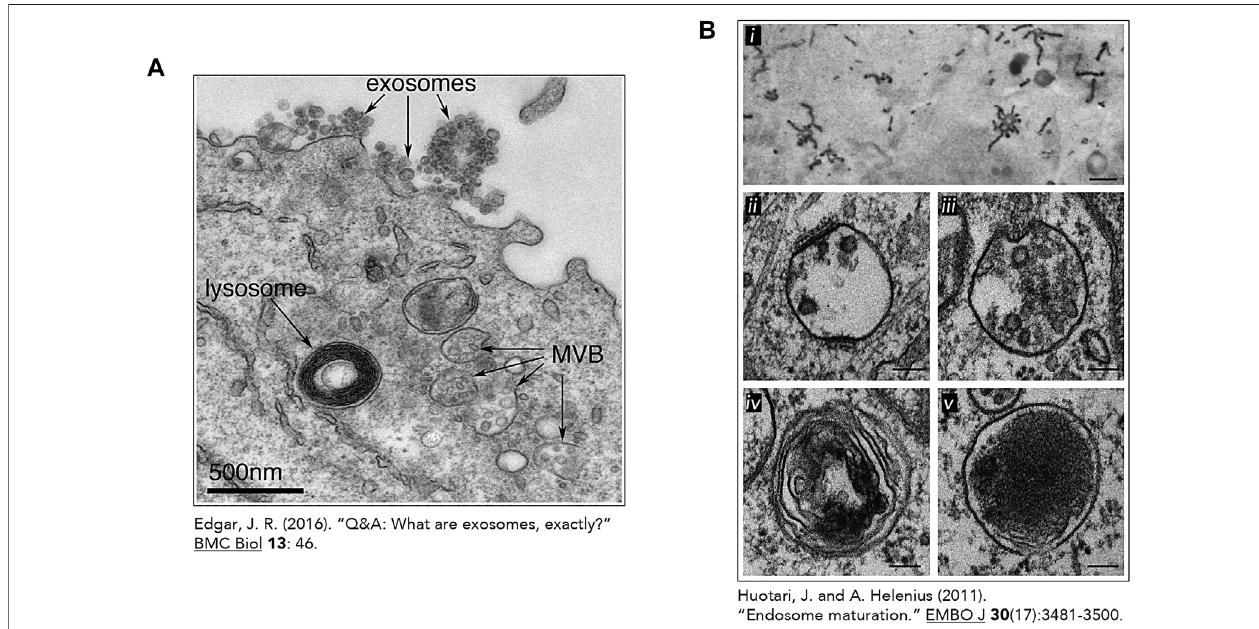
FIGURE3| Theheterogeneousnatureofthelysosome.Transmissionelectronmicrographsoflysosomesandotherrelatedorganelles(HuotariandHelenius,2011; Edgar, 2016). (A) Lysosome identi fi ed by an arrow in an Epstein-Barr virus-transformed B cell displaying an increase exosome release. This image was made freely available under the Creative Commons Attribution 4.0 International Public License (Edgar JR. Originally published in BMC Biology . 2016; 14:46. DOI 10.1186/s12915- 016-0268-z). (B) Heterogeneous morphologies of endosomes and lysosomes. (i) Early Endosomes (EE) containing HRP-conjugated Transferrin (Tf) (500 nm) (ii) Early Endosomes containing intraluminal vesicles (ILV) and clathrin lattices (100 nm) (iii) Late Endosome and its associated ILVs. (100 nm) (iv) Endolysosome (by fusion ofalysosomeandendosome)(100 nm). (v) Micrographoflysosomeswithelectrondenselumen.(100 nm). (B)(i) wasreproduced withpermissionfromTheRockefeller University Press ( © Copyright 1992 Tooze J and Hollinshead M. Originally published in The Journal of cell biology , 118 (4), 813 – 830. https://doi.org/10.1083/jcb.118.4. 813). Figure 3B ( ii-v ) was reproduces with permission from EMBO (Huotari, J., and Helenius, A. (2011). Endosome maturation. The EMBO journal , 30 (17), 3481 – 3500.